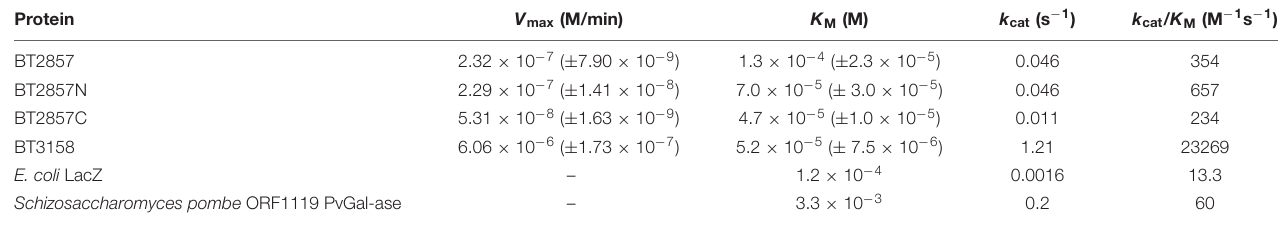
TABLE 3 | Michaelis–Menten kinetic values calculated for BT2857 and BT3158 E. coli LacZ and PvGal-ase.